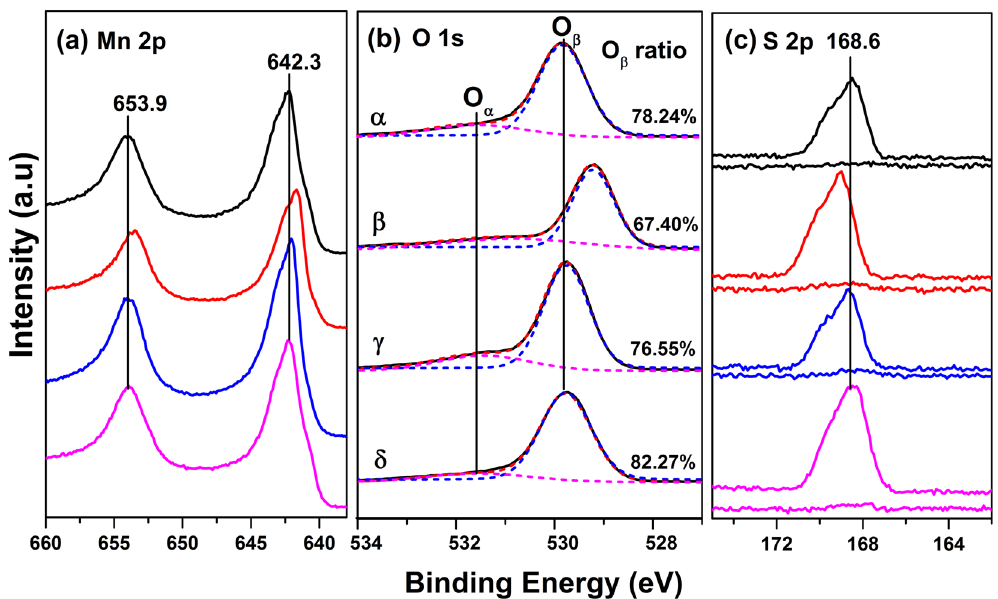
Figure 7. XPS spectra of α -, β -, γ - and δ -MnO 2 : ( a ) Mn 2p, ( b ) O 1 s, ( c ) S